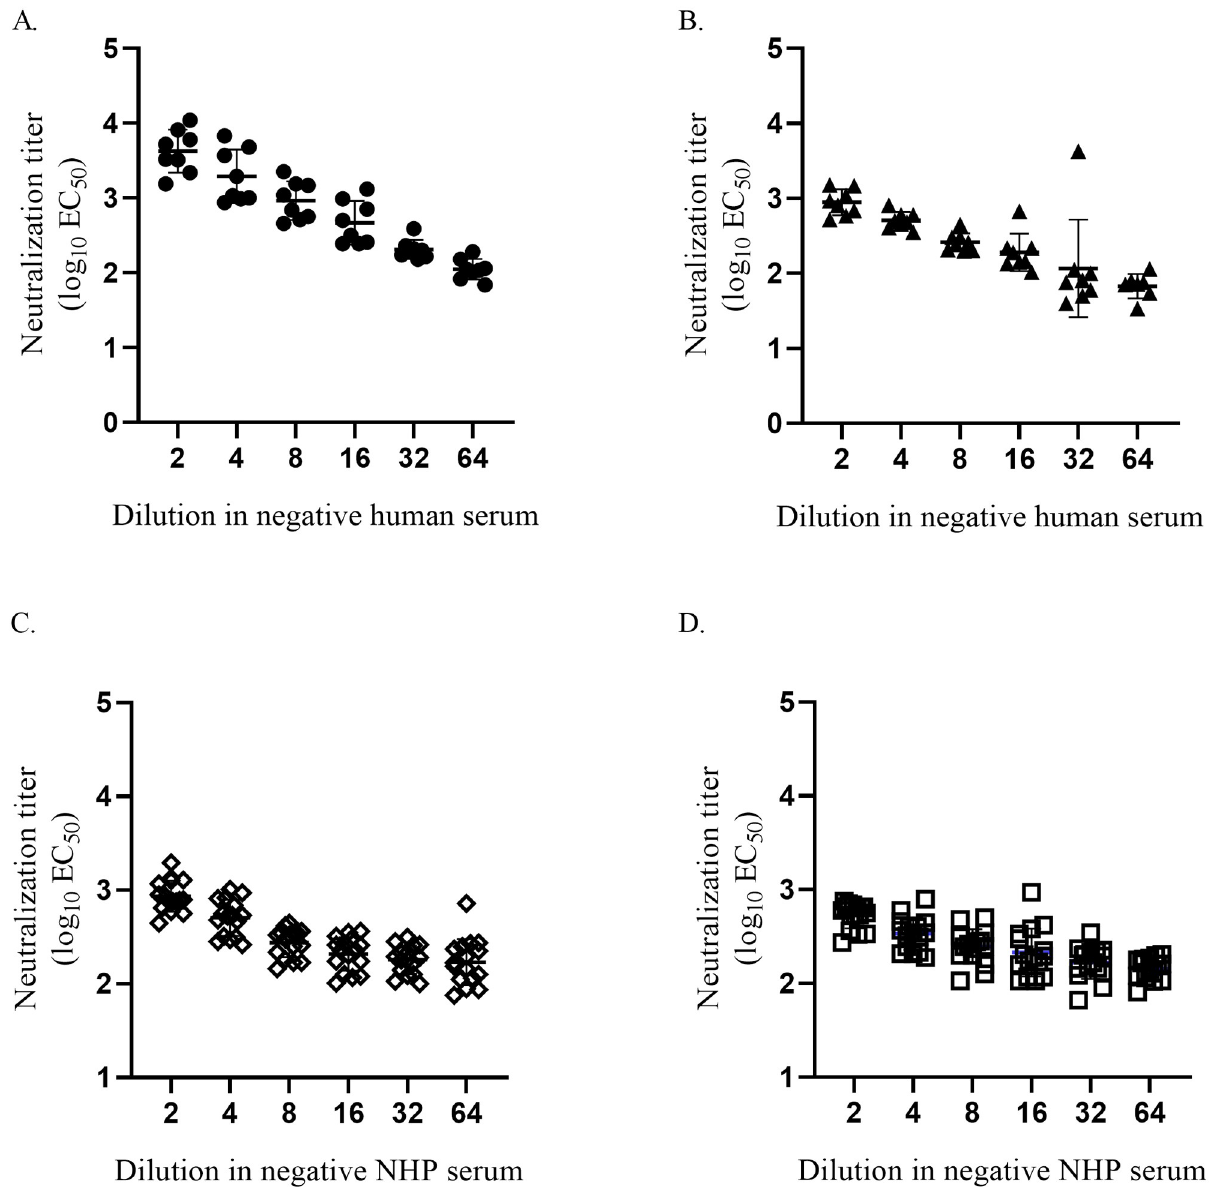
Fig 5. Dilutional linearity of the Z-RVP-384 assay in serum matrix. (A, B) Two positive human sera were diluted in negative human serum. (C, D ) Two positive cynomolgus macaque sera were diluted in negative cynomolgus macaque serum. Serial dilutions test stocks were generated and titrated 8–16